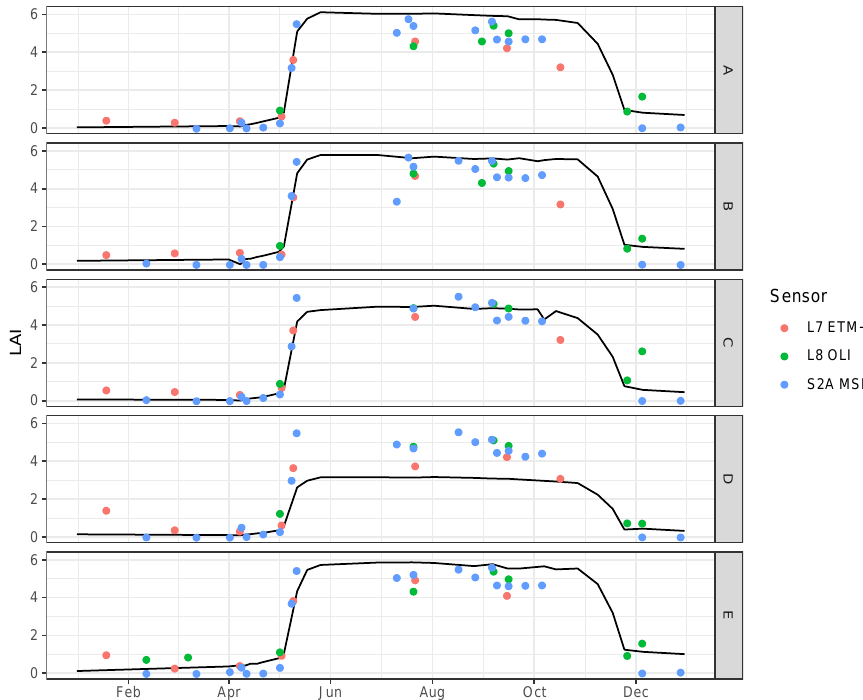
Figure 11. Best performing realisation in terms of RMSE over the 2016 study period. Black solid line is the validation time